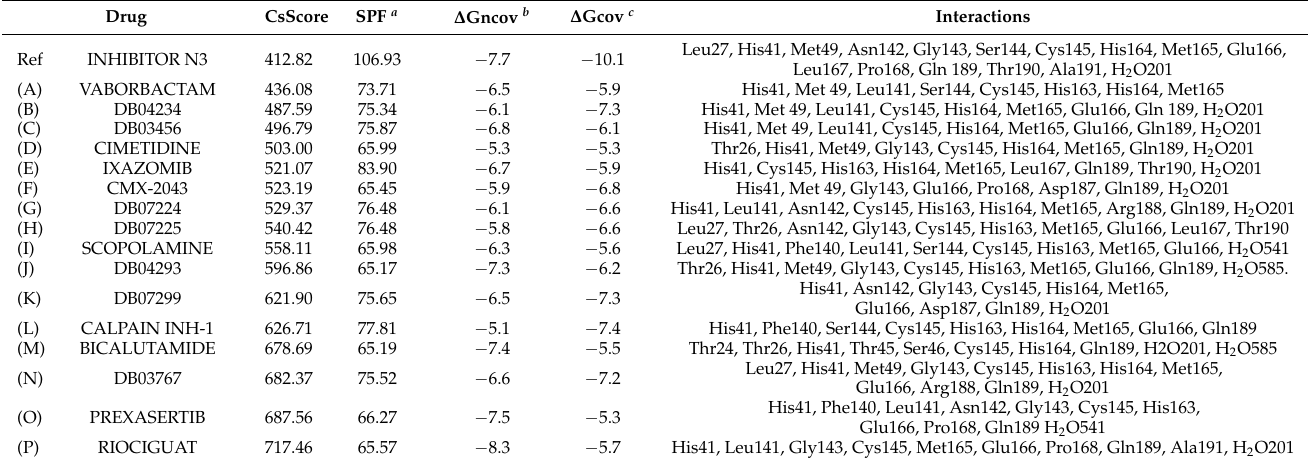
a S PF = Pharmacophore-fit score, Fit value indicates how well the features in the pharmacophore map with the chemical features present in the compound. b ∆ G ncov = Affinity energy calculated in Autodock Vina 1.1.; c ∆ G cov = Affinity energy calculated by covalent